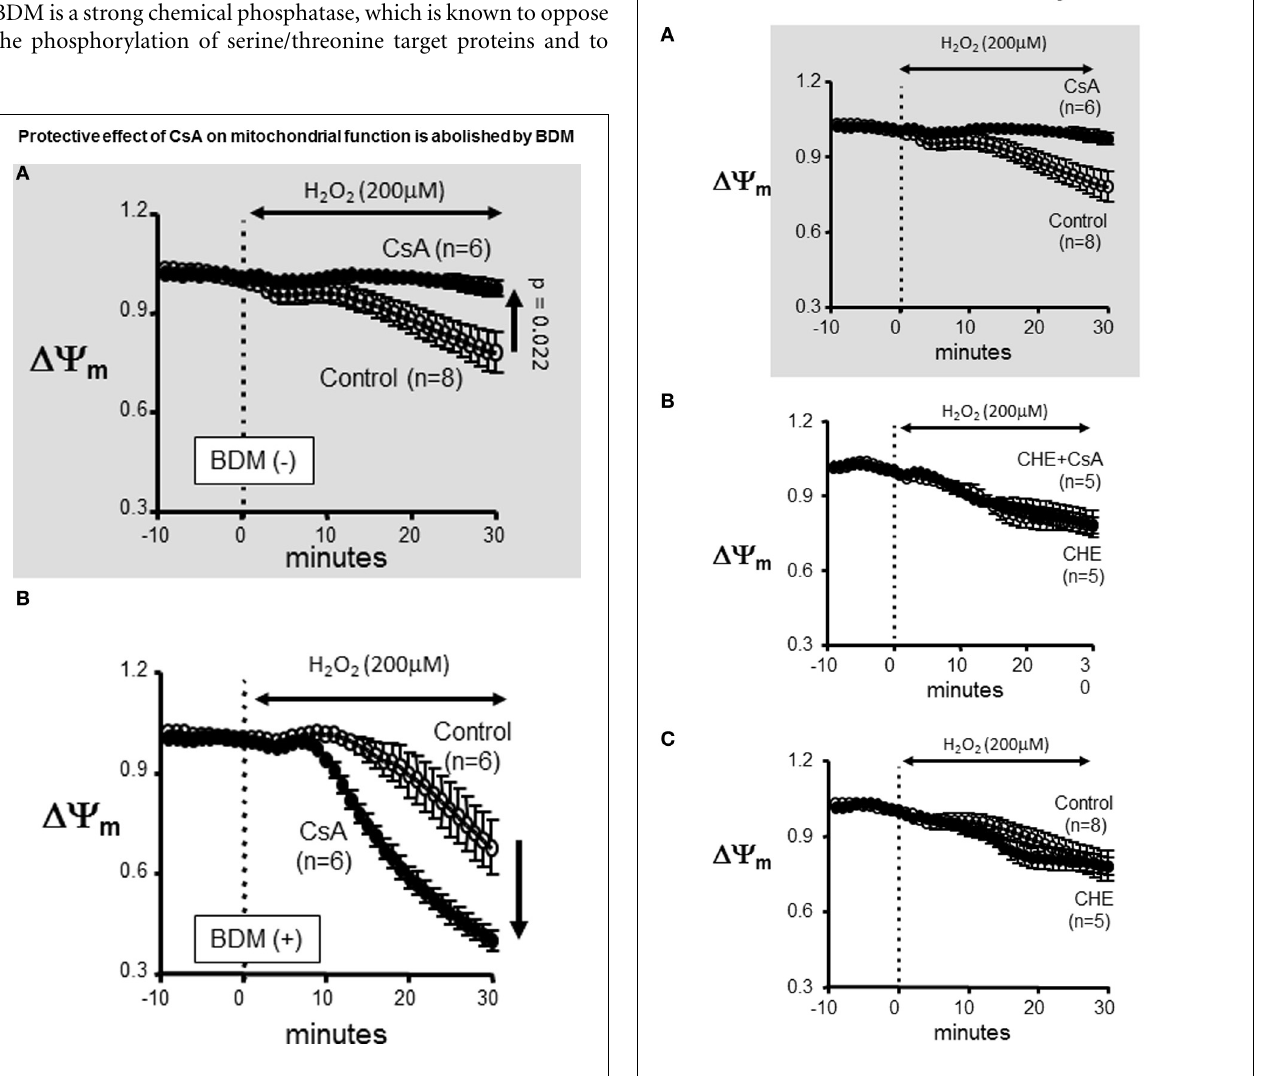
FIGURE 3 | Protective effect of CsA on mitochondrial function is abolished by BDM. Treatment with the chemical phosphatase BDM abolishes the protective effects of CsA. (A) For reference, (cid:2)(cid:3) m response presented in Figure 1 indicating protection by CsA against OS-induced (cid:2)(cid:3) m depolarization. (B) Addition of the chemical phosphatase BDM (10mM) reversed the effect of CsA on (cid:2)(cid:3) m . BDM, 2,3-Butanedione monoxime.